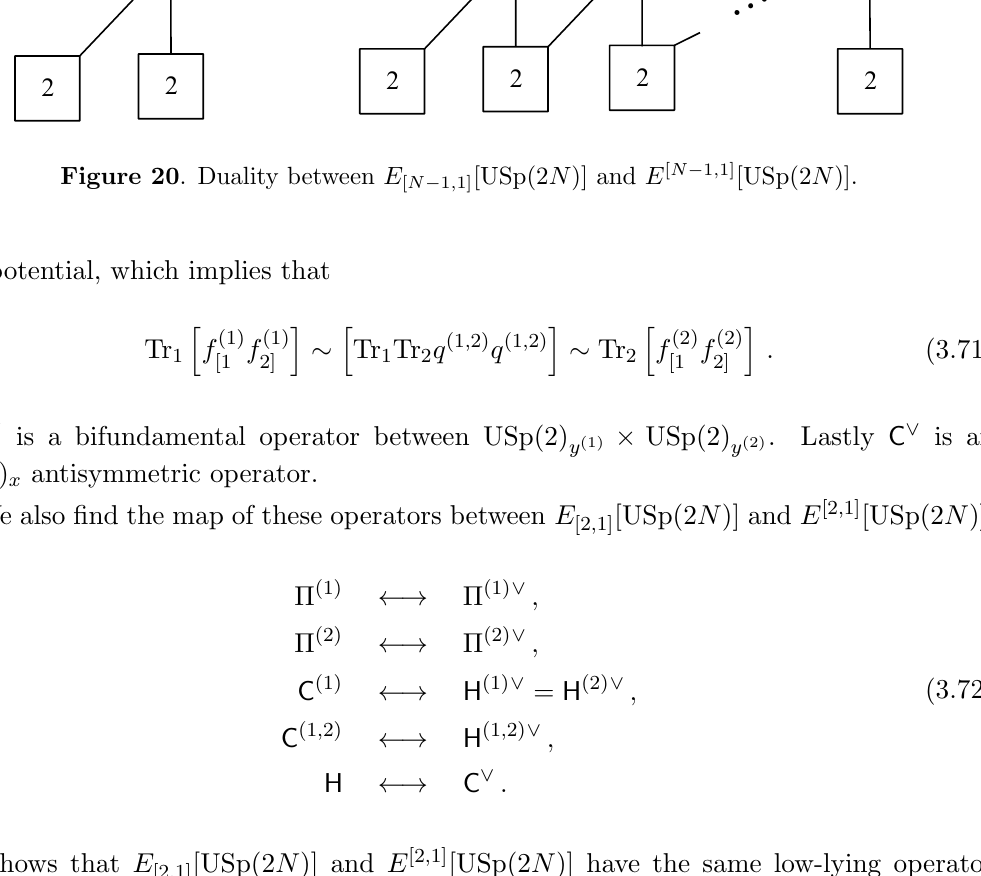
Figure 20 . Duality between E